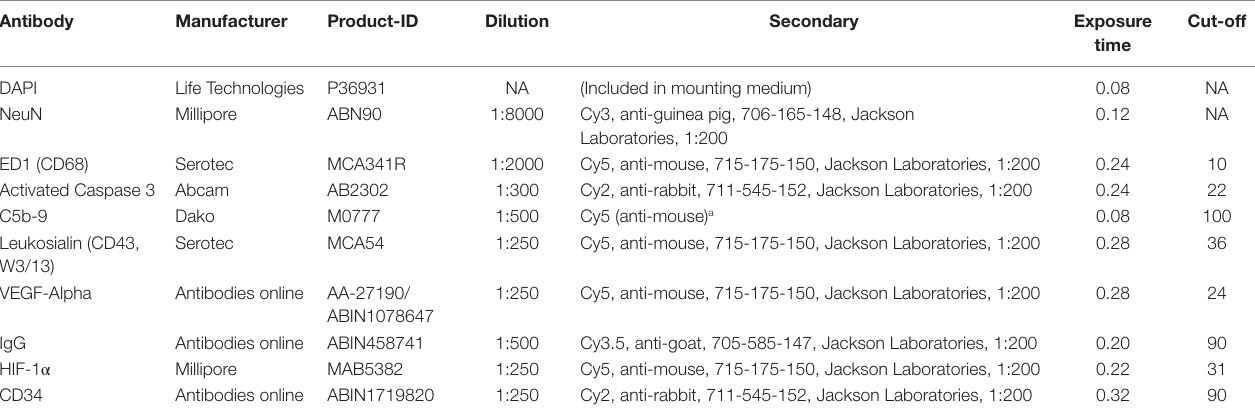
TaBle 1 | Primary and secondary